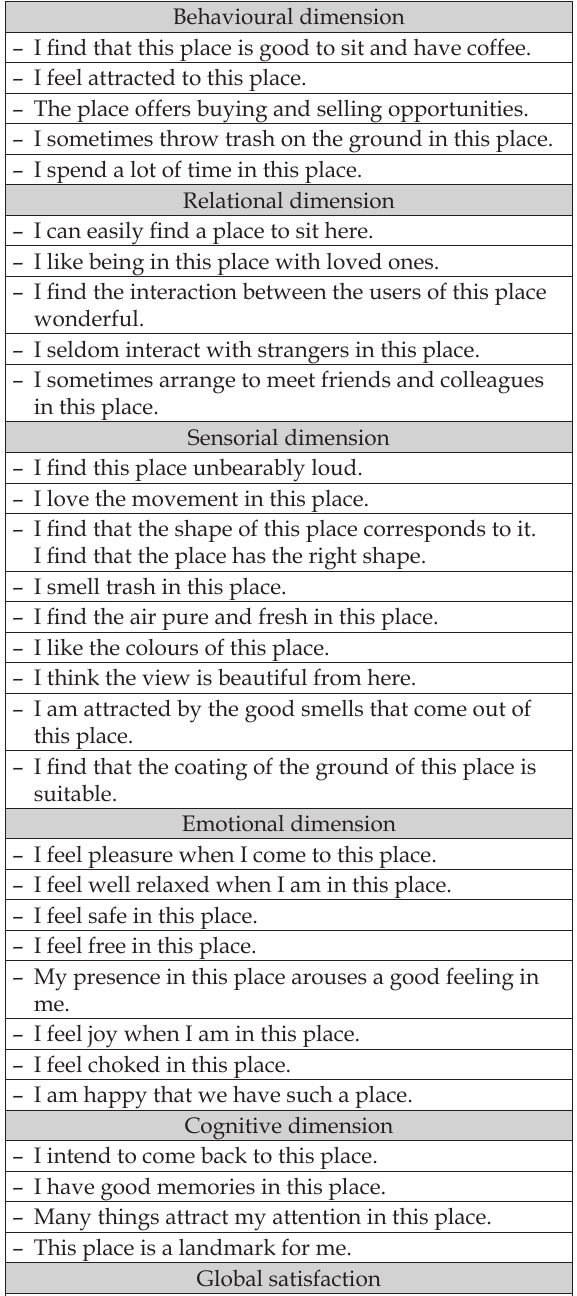
Table 4. Items of the different dimensions of the expe- riential tool of public